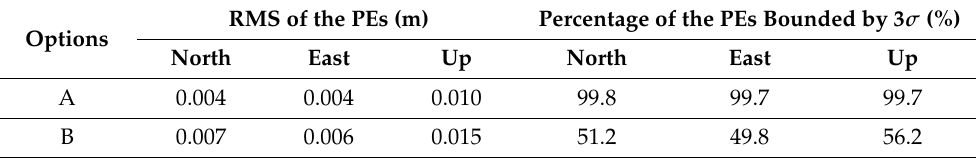
Figure 6. Positioning errors (PEs) of the user at the worst location in Network 1 and three times their formal standard deviations for: ( a ) Option A; ( b ) Option B. Table 5. Statistics of the positioning results under different options for user at the worst location in Network